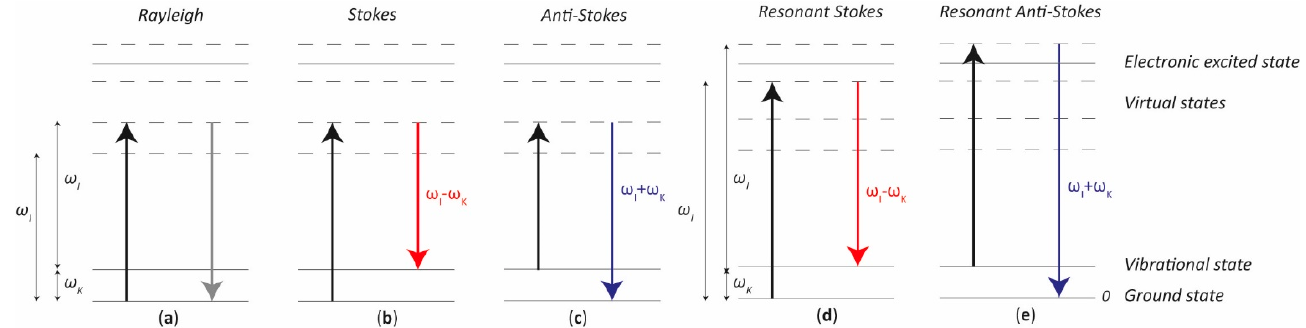
Figure 1. Simplified ( a ) Rayleigh, ( b ) non-resonant Stokes Raman, ( c ) non-resonant Anti-Stokes Raman, ( d ) resonant Stokes Raman, and ( e ) resonant anti-Stokes Raman scatterings. The arrows represent the electron jump from one state to the other: in black when the photon energy is absorbed, in grey when a Rayleigh scattering happens, in red and blue when Stokes and anti-Stokes Raman scattering respectively happen.